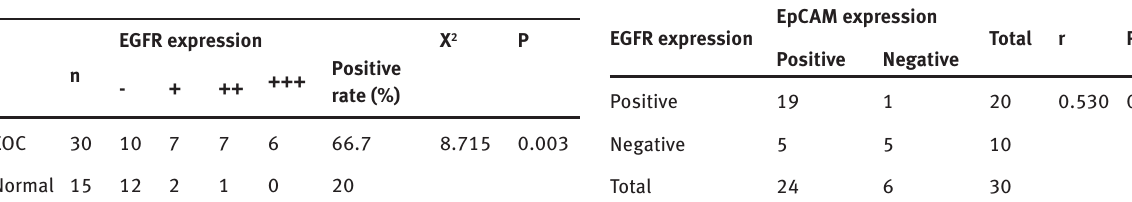
Table 3: Chi-square test analyses of EGFR expression in EOCs and normal ovaries